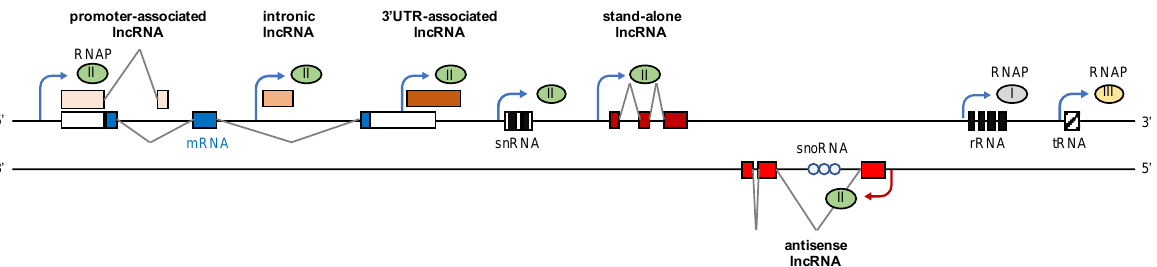
Figure 1. Transcription units of the genome. The human genome engages three RNA polymerases (RNAPs) for RNA synthesis. RNAPII (green) produces both protein-coding messenger (m)RNA transcripts and long non-coding (lnc)RNA transcripts from sense (blue arrowhead) and antisense (red arrowhead) promoters. RNAPII also produces small nuclear (sn)RNA and small nucleolar (sno)RNA. RNAPI (grey) and RNAPIII (yellow) produce non-coding ribosomal (r)RNA and transfer (t)RNA, respectively. White box, non-protein-coding exon; blue box, protein-coding exon; red box, lncRNA-coding exon; 3′UTR, 3′ untranslated region. The transcription units are not in scal e.